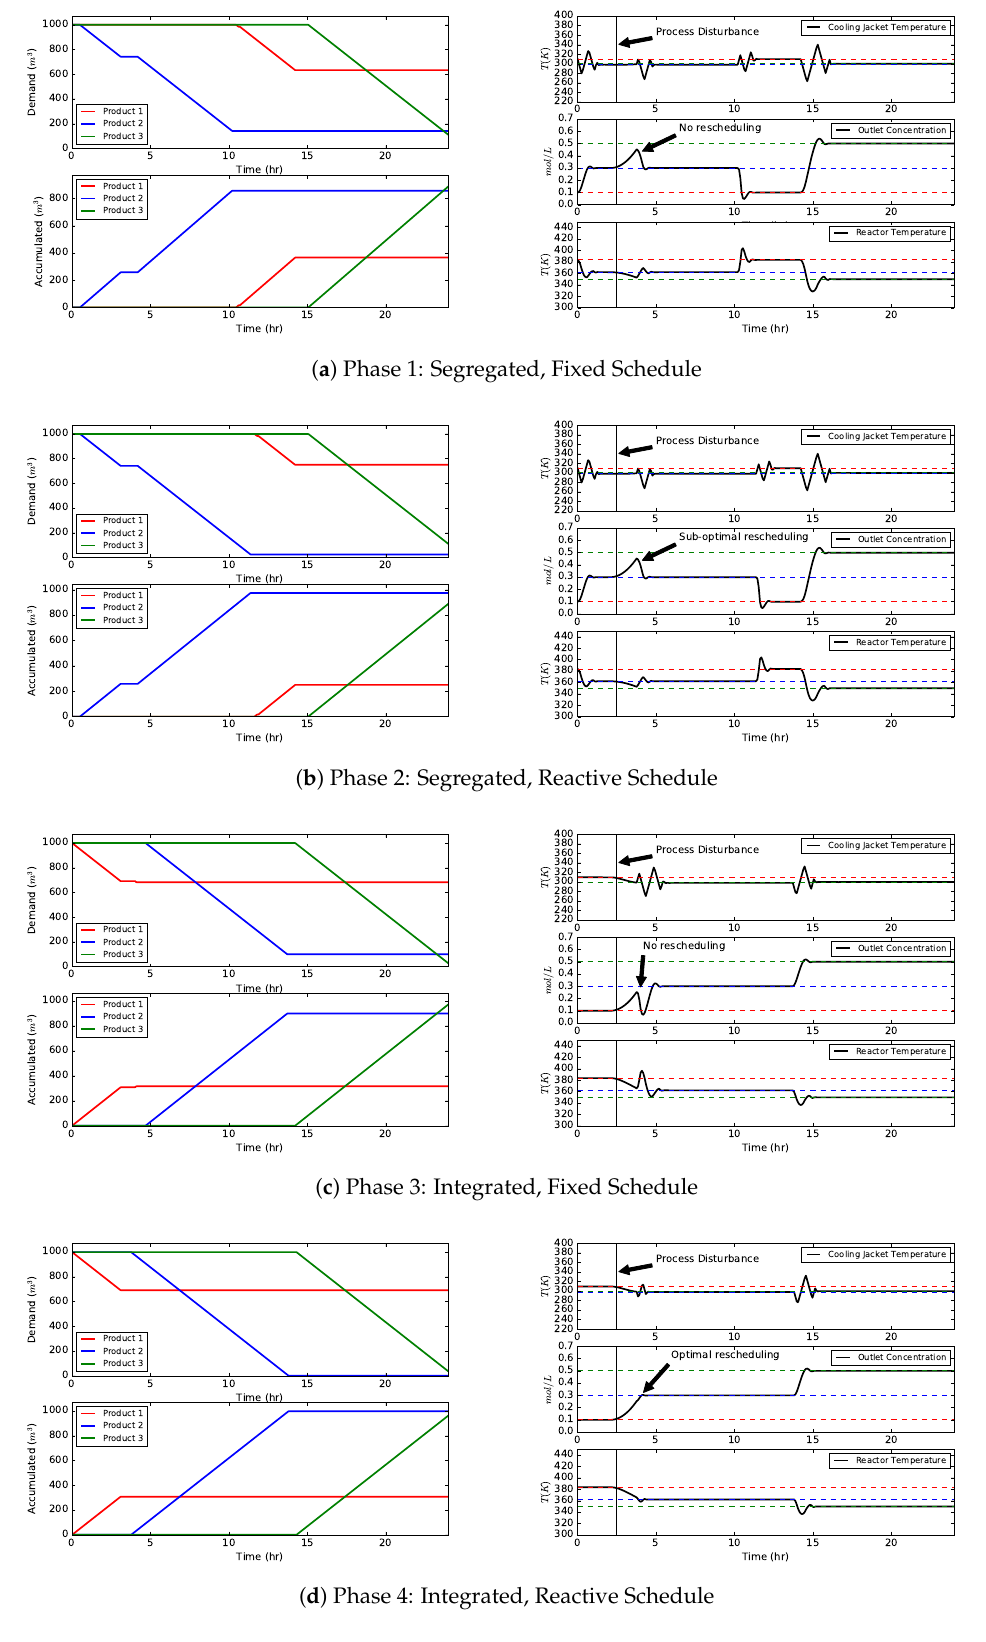
Figure 5. Scenario A: Process